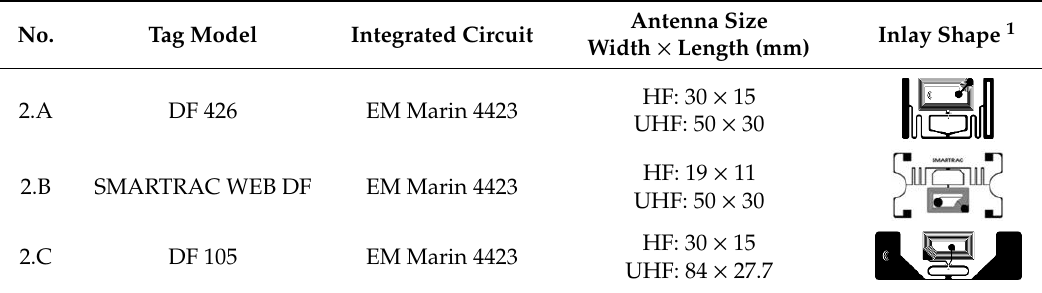
Table 3. Technical specifications of Near Field Communication tags tested on the test bench in Figure 3.